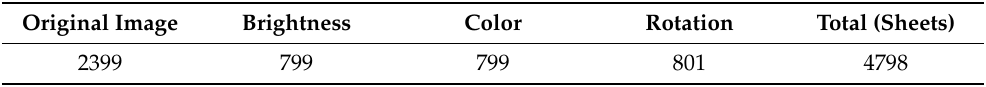
Table 1. Image data